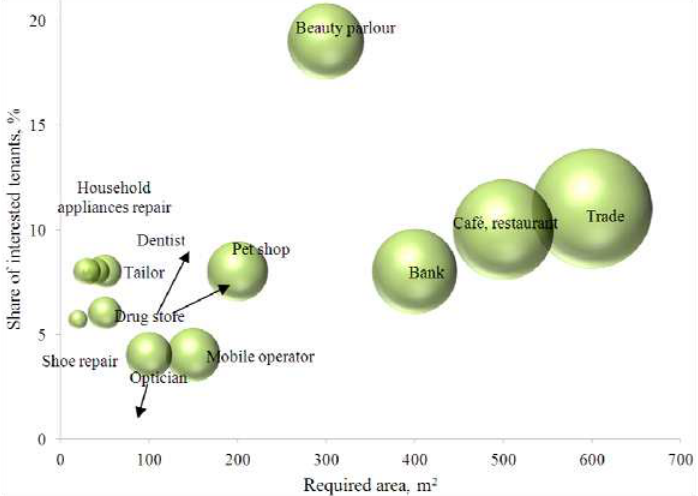
Fig. 6. Potential tenants’ services